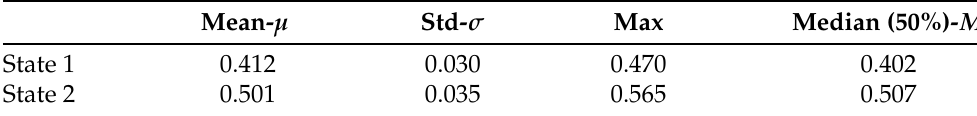
Table 1. The summary statistic of the identified states.